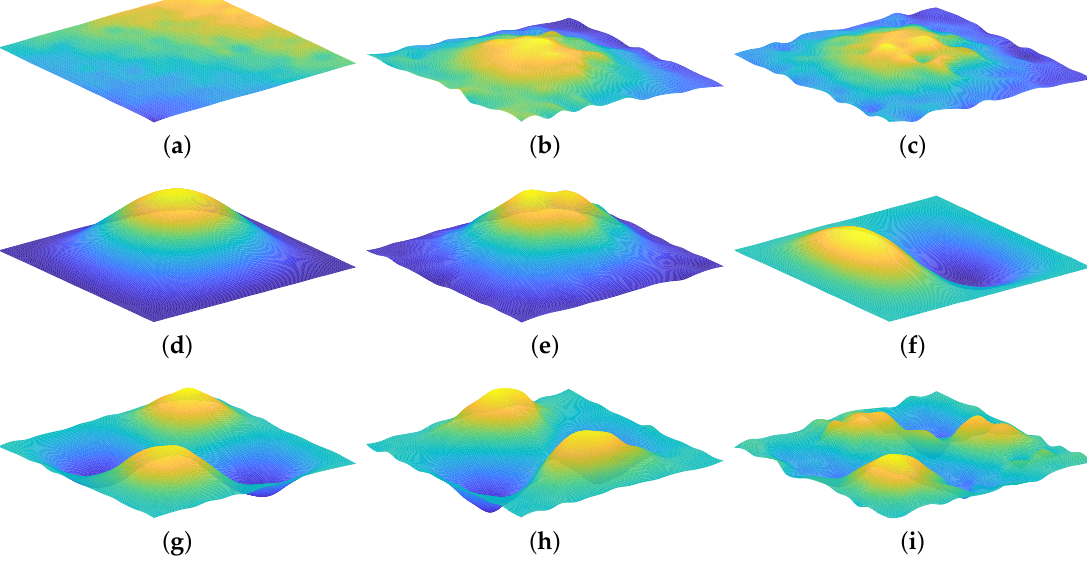
Figure 15. Plate vibration forms (plate thickness t = 1mm). ( a ) Plate vibration at f = 11.875Hz; ( b ) Plate vibration at f = 45Hz; ( c ) Plate vibration at f = 164.375Hz; ( d ) First shape mode at f = 353.125Hz; ( e ) Plate vibration at f = 396.875Hz; ( f ) Second shape mode at f = 736.25Hz; ( g ) Third shape mode at f = 1111.875Hz; ( h ) Forth shape mode at f = 1356.875Hz; ( i ) Fifth shape mode at f =